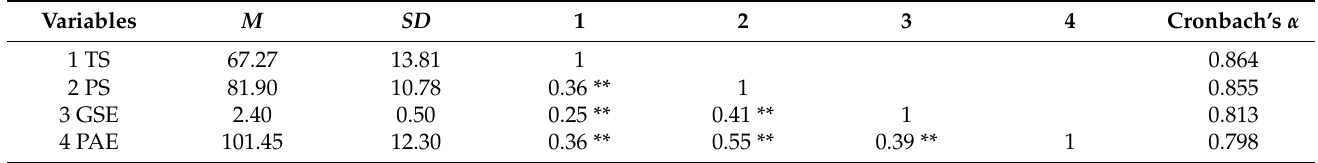
Table 1. Means, SDs, correlations, and Cronbach’s alphas among TS, PS, GSE, and PAE (N =